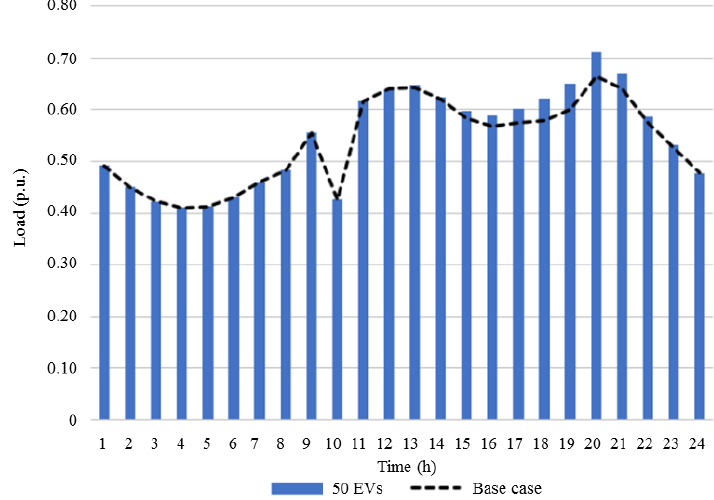
Figure 13. Load demand comparison between the base case and Case 4 (50 EVs, uncontrolled charging).